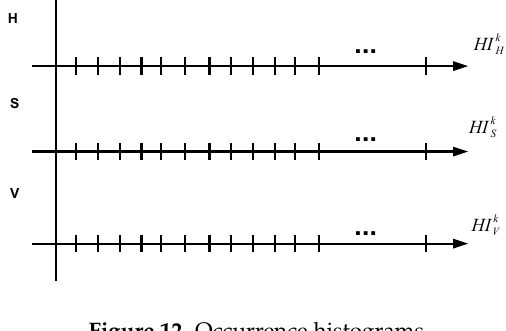
Figure 12. Occurrence